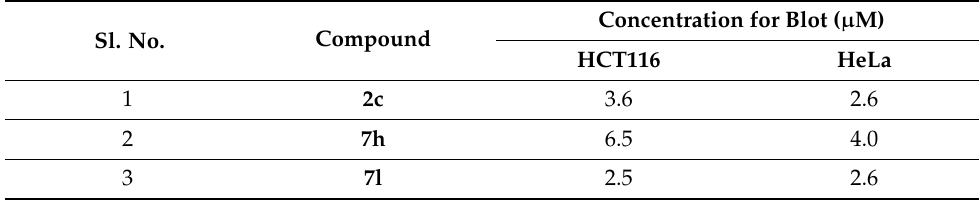
Table 3. Concentration of compounds 2c , 7h and 7l for immunoblot assay in HCT116 and HeLa cell